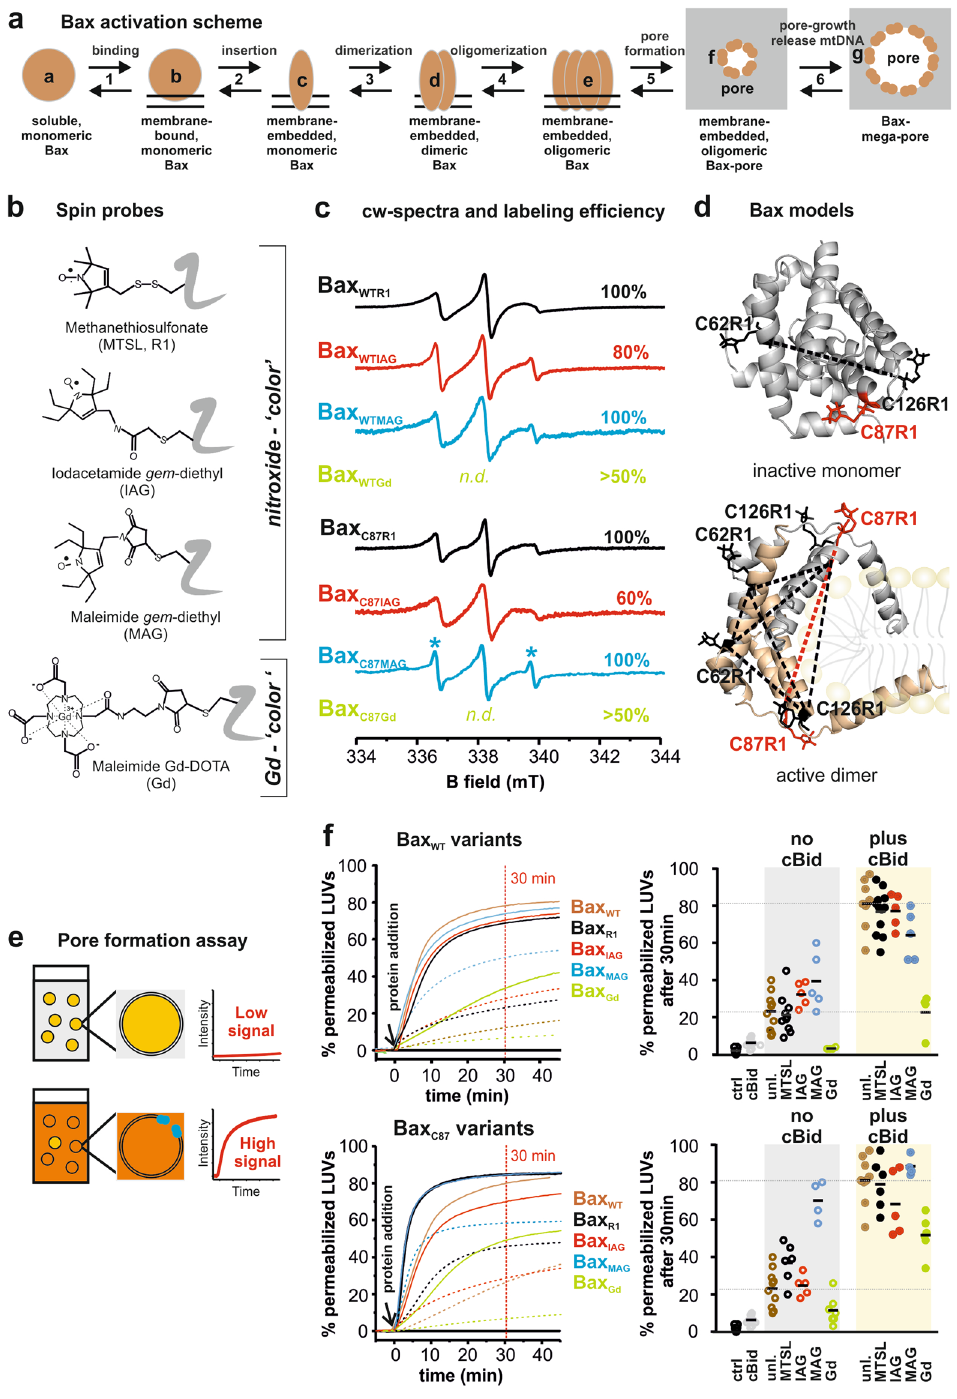
Figure 1. Bax activation scheme, spin labeling and activity assays. ( a ) Sketch of conformational changes of Bax during activation. The protein exists at least in seven conformational states ( a-g ). Soluble monomeric Bax (state “ a ”) can transiently interact with the mitochondrial outer membrane MOM (“ b ”). Upon interaction with an activator-type BH3-only protein membrane insertion is induced (“ c ”) 20,22 followed by the formation of homo- dimers (“ d ”) that assemble into higher order oligomers 10,18,22,24 (“ e ”). The oligomers form a toroidal pore in the MOM allowing the release of Cyt c 39,59 (“ f ”). These pores can grow to “mega-pores” able to release mitochondrial DNA 14,17 . ( b ) The four spin labels used in this study, targeting cysteine residues. ( c ) Room temperature cw spectra of the nitroxide-labeled proteins, with the degree of labeling (spin/cysteine ratio) indicated in %. Asterisks indicate residual free label. For Gd-labeled Bax see Supp. Fig. 2. ( d ) Structural models of monomeric 12 and dimeric active Bax 18 with one MTSL (R1) label attached per site using the software MMM 55 . Intra- and inter- monomer distances are highlighted by dotted lines (black for the wild type variants, red for the C87 variants). ( e ) Graphical scheme of the assay used to address Bax-induced pore formation. ( f ) Kinetic